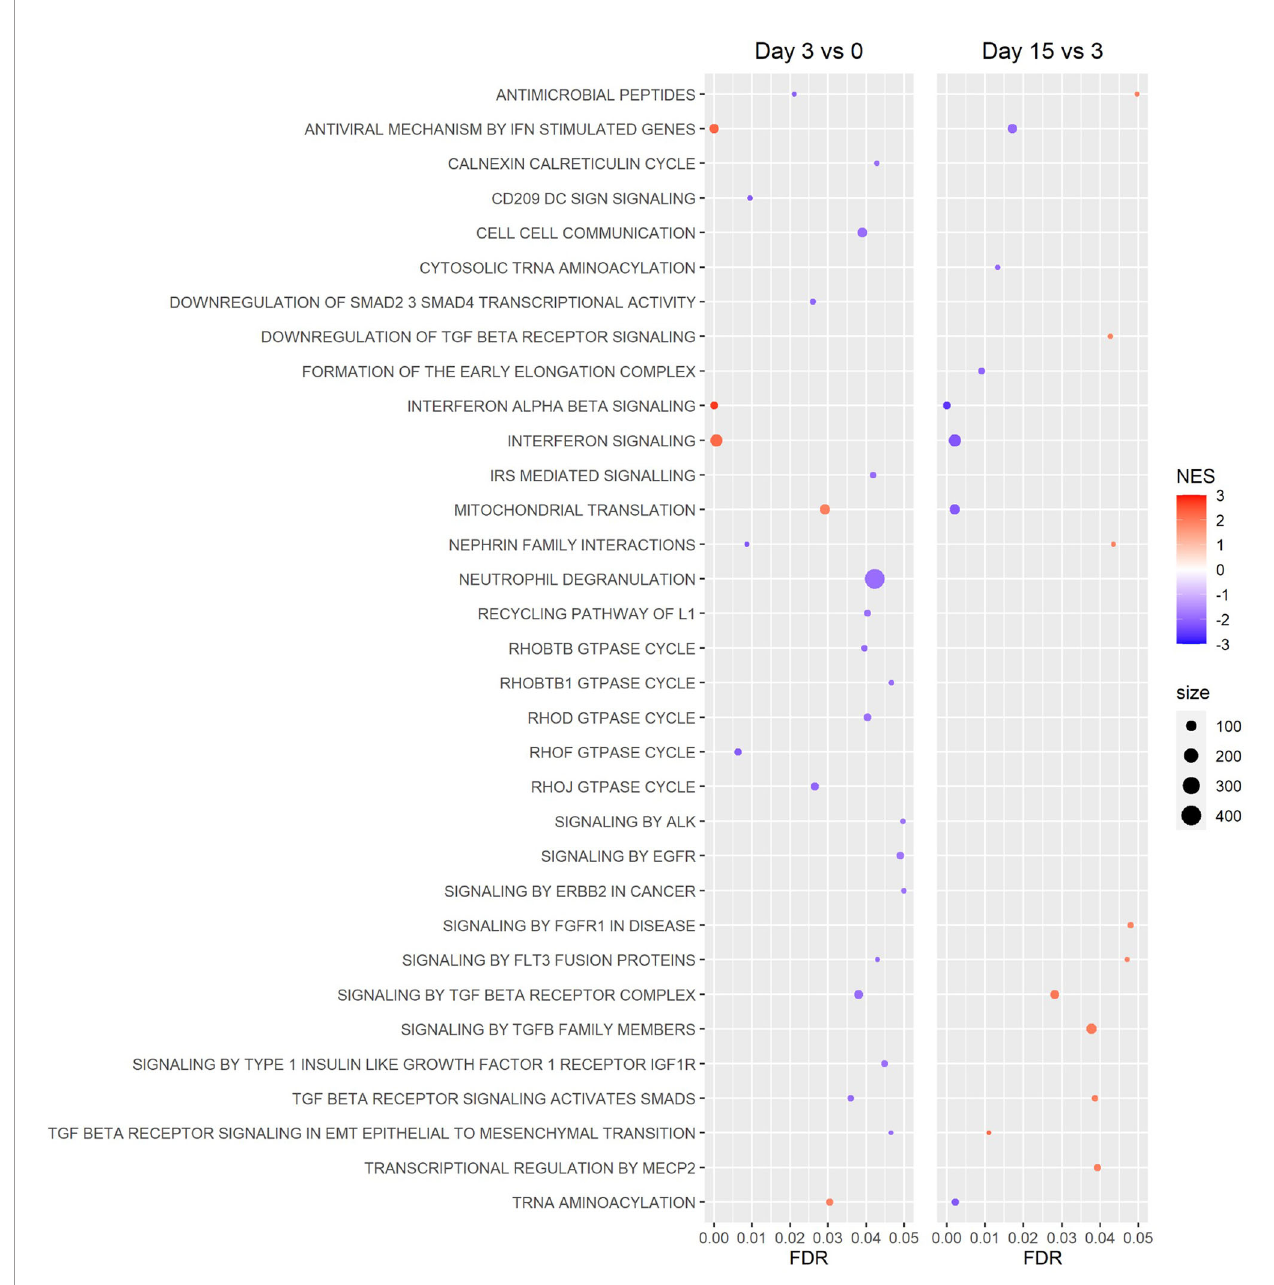
FIGURE 6 | Gene Set Enrichment Analysis (GSEA) of Reactome canonical pathways. Gene sets revealed a pattern of increased expression of genes associated with interferon signaling and antiviral mechanisms between the beginning and peak of infection (day 3 vs 0), then decreased expression of these genes between the peak and resolution of infection (day 15 vs 3). No fi gure was included for the day 15 vs 0 comparison because no gene sets were signi fi cantly enriched. (NES: Normalized Enrichment